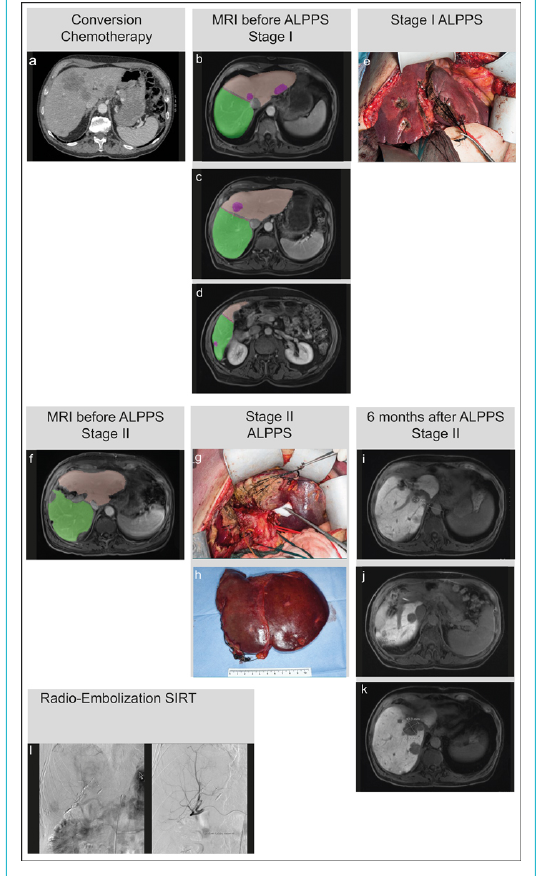
Figure 2: Treatment algorithm for an individual patient with bilobar colorectal liver metastasis at the Swiss HPB Centre, Zurich, Switzerland. (a) Start of chemotherapy. (b–d) MRI (Primovist) glob- al reduction of all lesions. Lesion: 22.4 cm 3 , FLR right liver: 58.69% / 742 cm 3 . (e) Intraoperative situs ALPPS Stage I. (f) MRI (Primo- vist) one week after Stage I: clean FLR (right lobe) with 901 cm 3 and adequate compensatory overgrowth before Stage II. g) Intra- operative situs ALLPS Stage II. (h) Anatomical specimen after he- patectomy. (i–k) 6 months after surgery, CRLM reappears. (l) hy- pervascucularised CRLM poor in contrast with selective probing